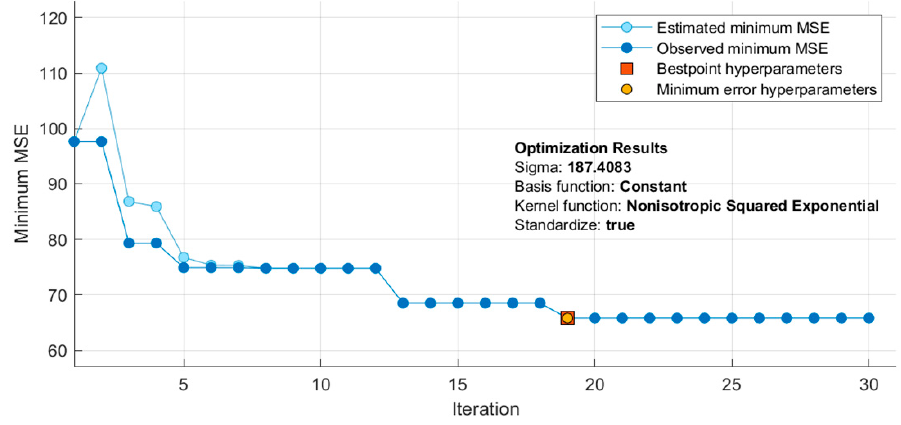
Figure 13. Optimization of the Gaussian process regression (GPR) model during training.